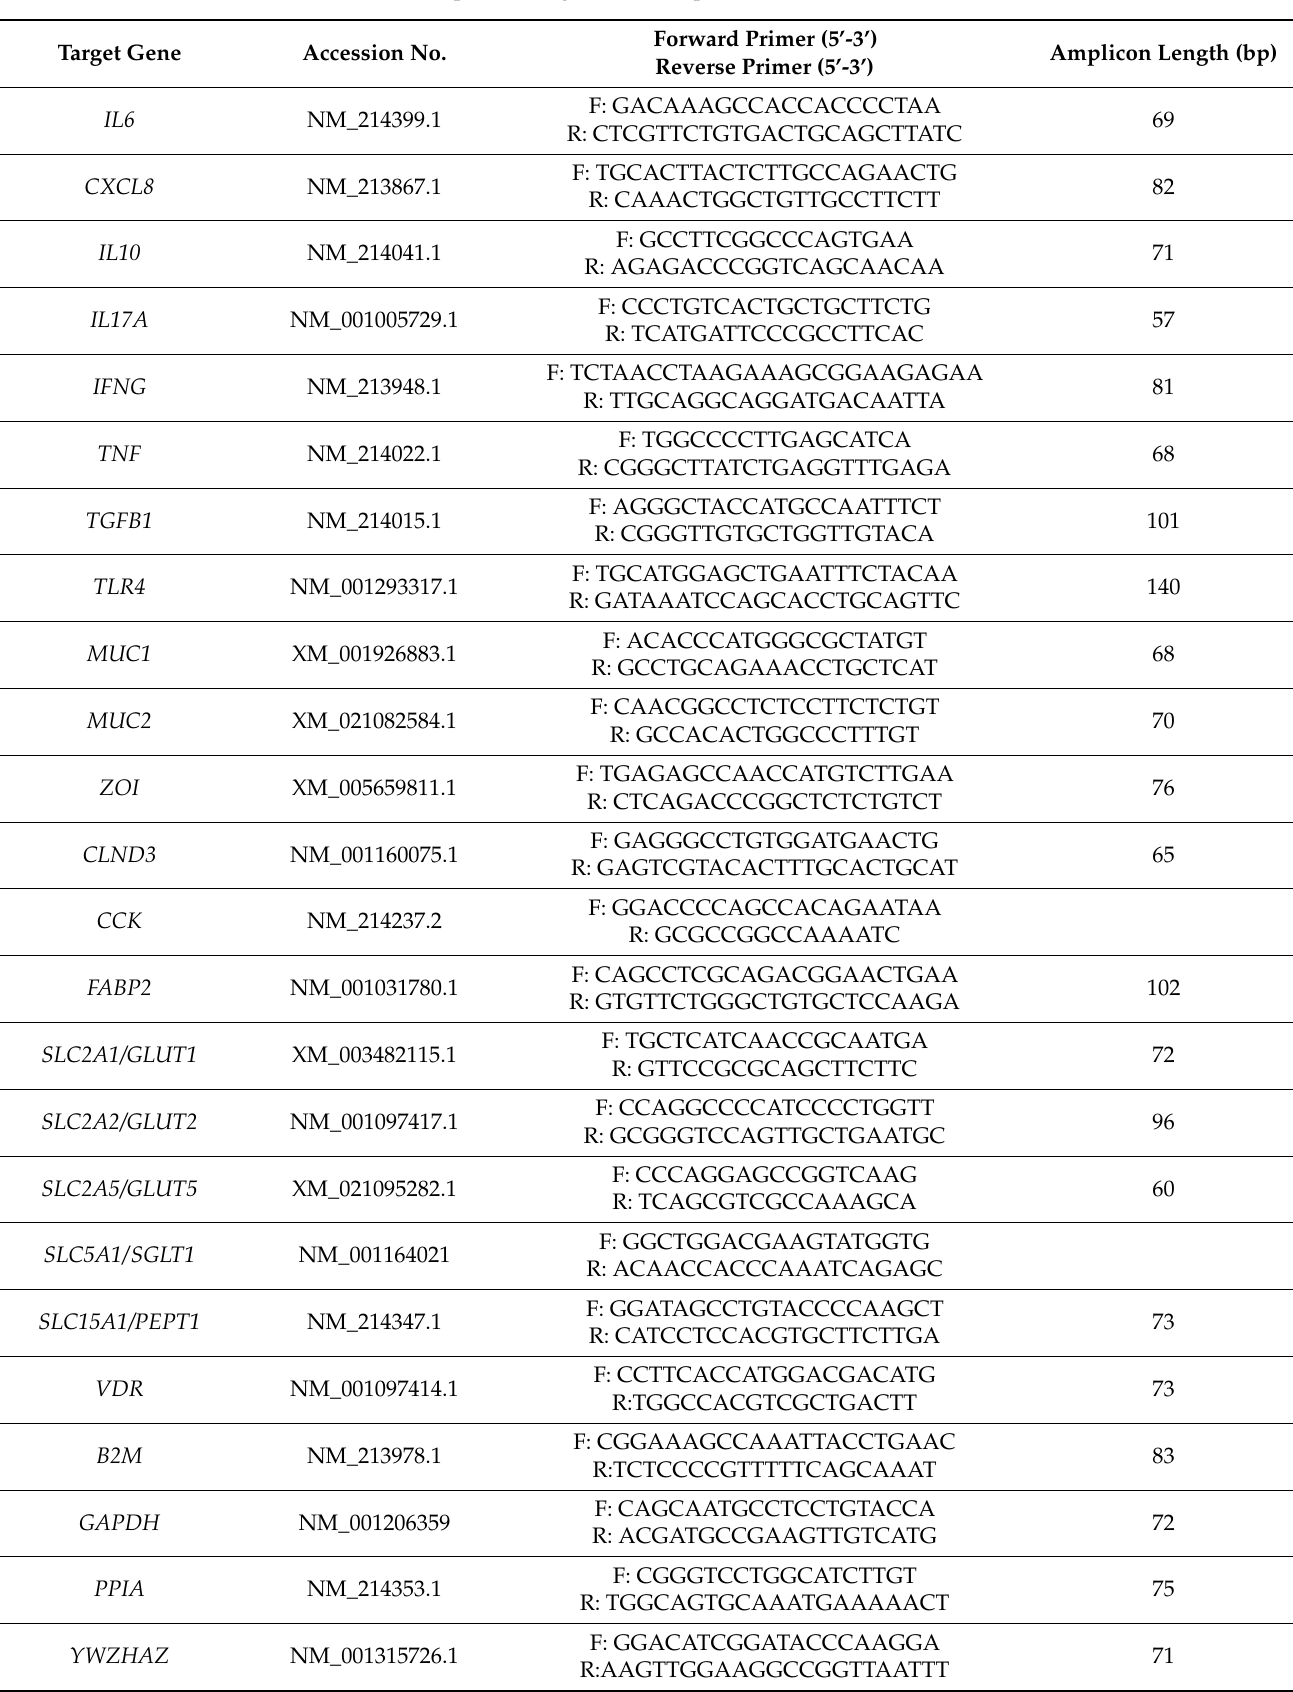
Table 2. Panel of porcine oligonucleotide primers used for real-time